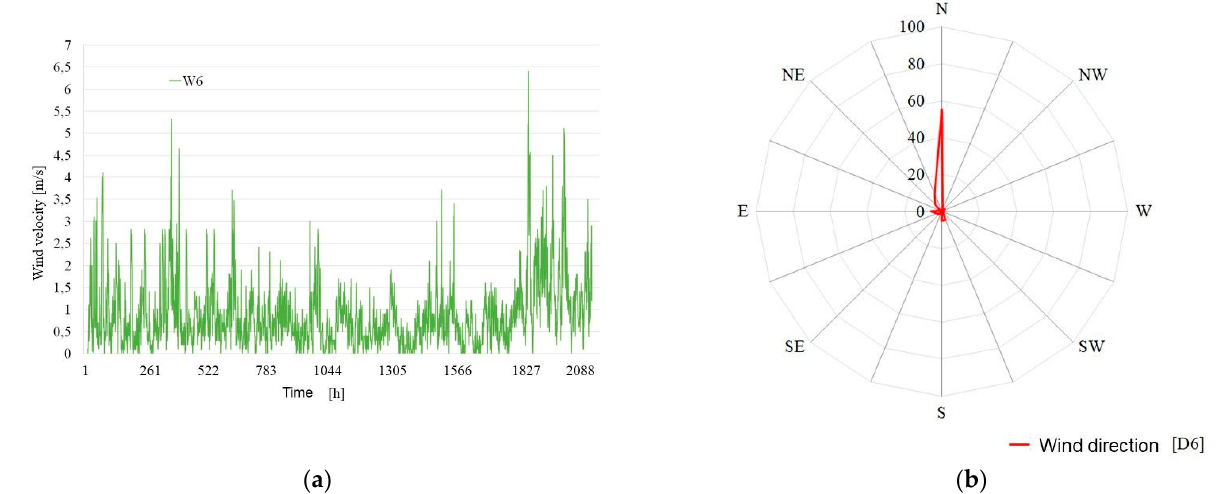
Figure 8. Information about wind: ( a ) wind velocity, ( b ) wind direction. As the research was carried out from August to November, most of the measured radiation intensity during the day exceeded the value of 100 [W/m 2 ]. The measured intensity of solar radiation presented in (Figure 9) refers to the value of total solar radiation on the horizontal surface. Based on the measured values of solar radiation intensity from the NR LITE2 m (Kipp&Zonen), total solar radiation intensity Ic was obtained [15,16].